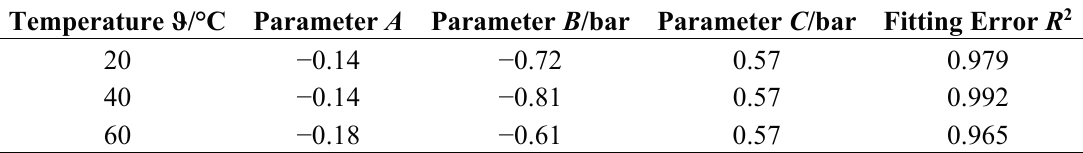
Table 3. Fitting parameters and fitting errors for maximum volume decrease ( Δ V / V 0 ) max